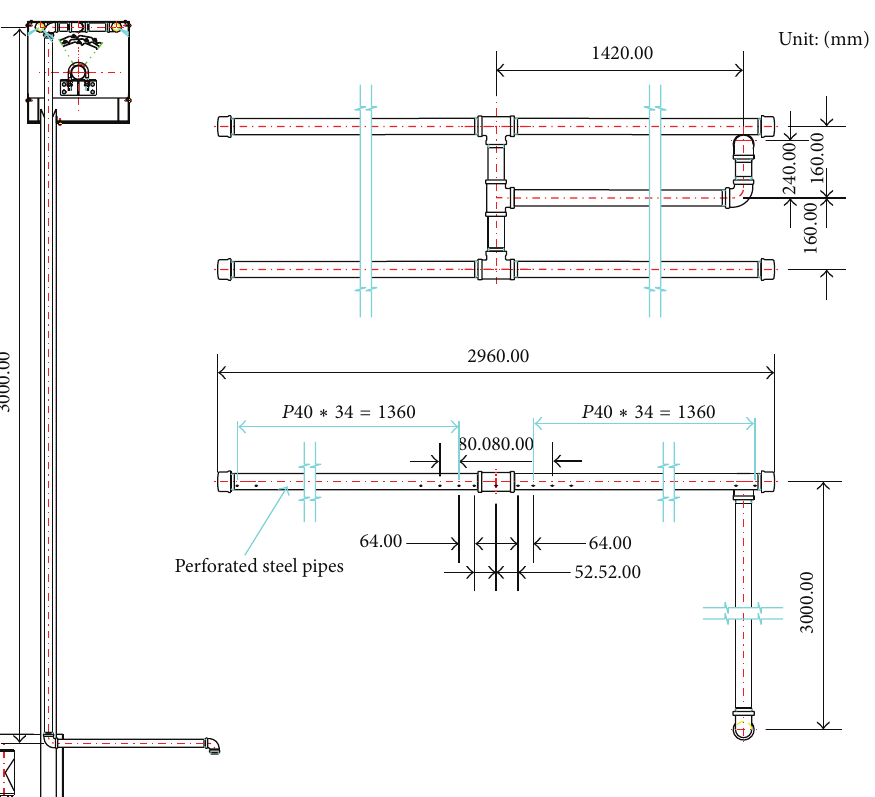
Figure 7: Perforated steel pipes and piping